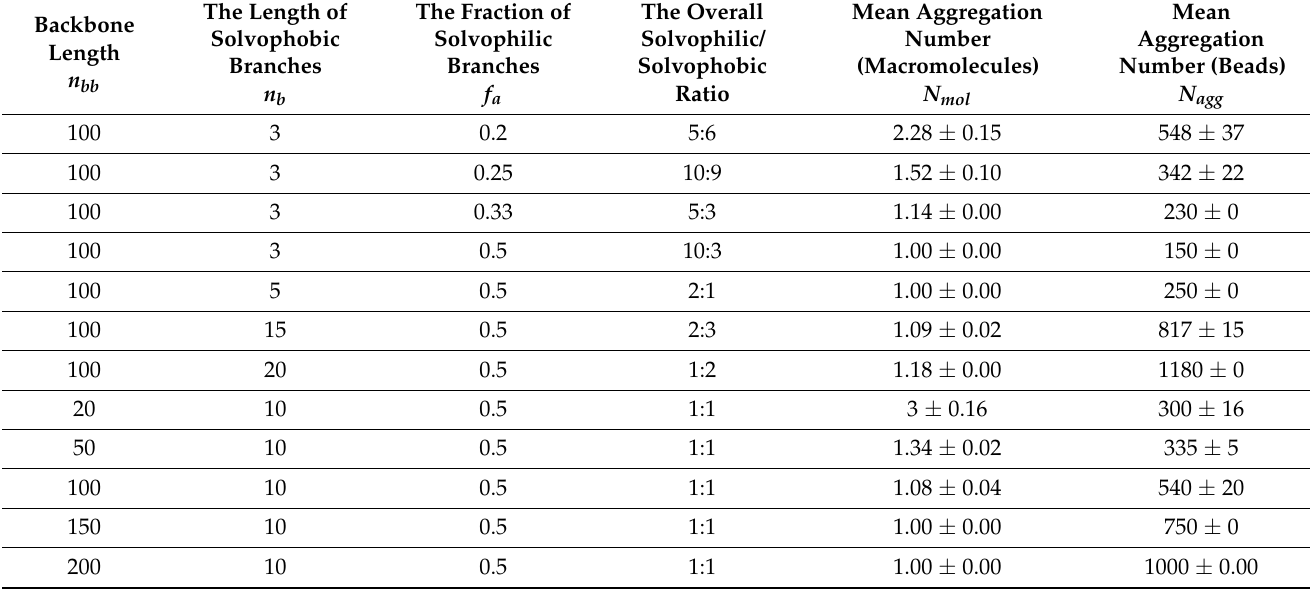
Table 1. Characteristics of amphiphilic bottlebrushes in a selective solvent. For each case, the length of solvophilic branches n a =